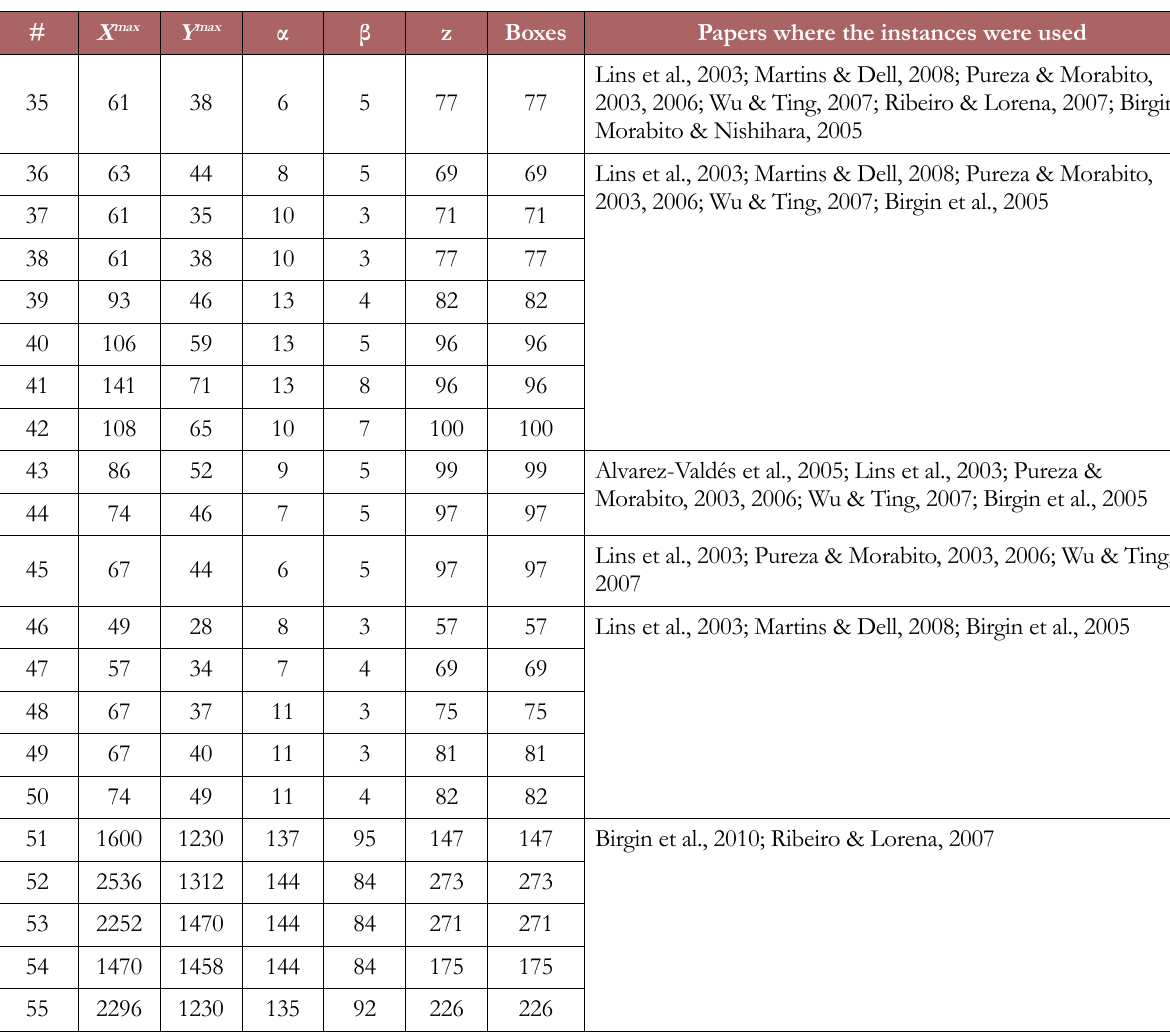
Table 2. Literature Instance Data-Sets with Block Approach results (Silva et al.,